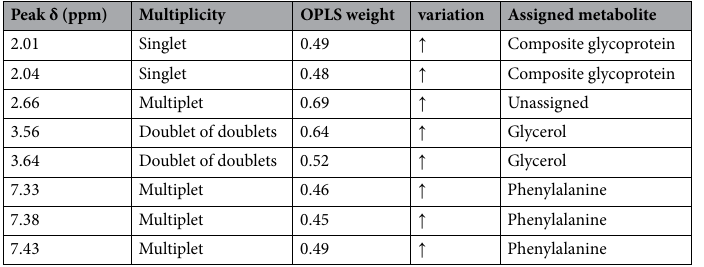
Table 3. List of selected signals from the OPLS model. Reported peaks showed an OPLS weight > 0.4. The OPLS weight value represent the R^2 for each metabolites.